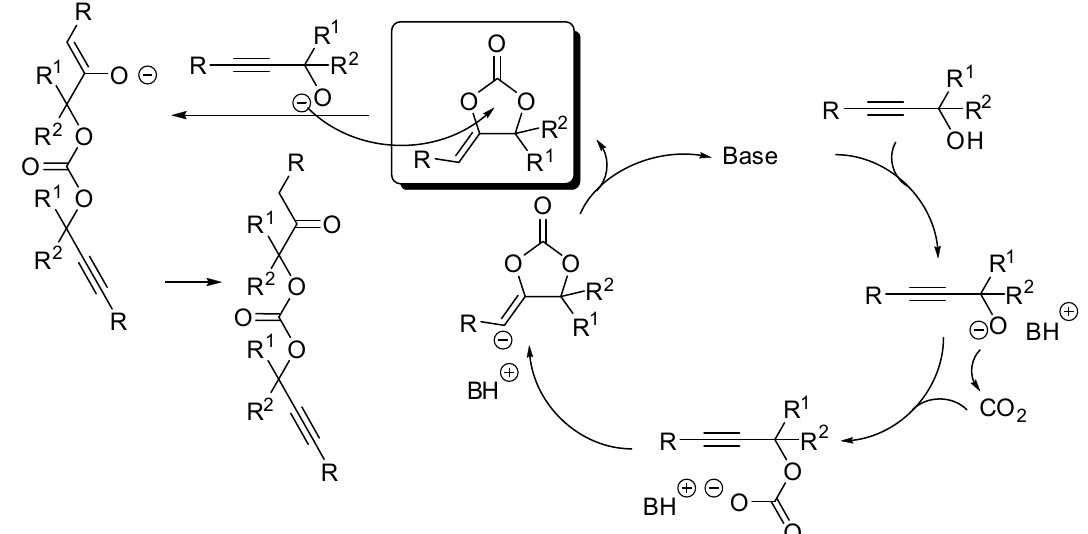
Table 2. Catalysts for the reaction of propargyl alcohols and carbon dioxide (R, R 1 and R 2 see Scheme 10). Entry R R 1 , R 2